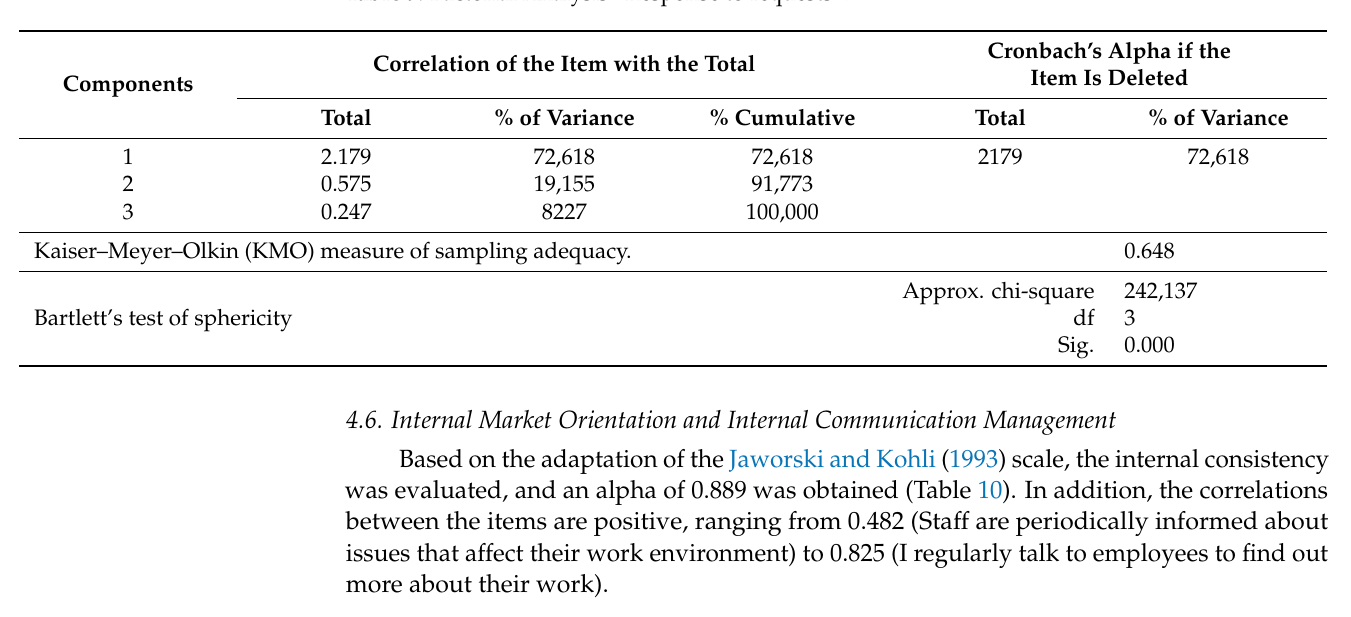
Table 9. Factorial Analysis “Response to requests”.